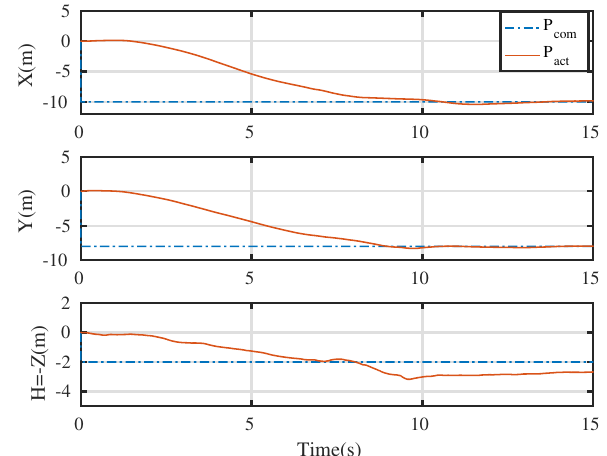
Figure 10. Position profile tracked during real-world flight test.